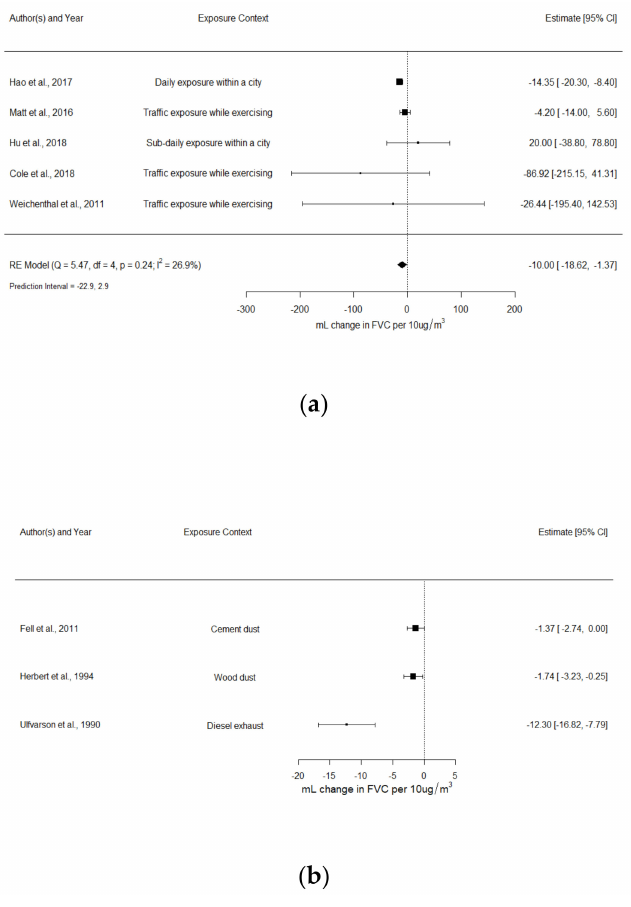
Figure 3. ( a ) Environmental PM 2.5 and FVC (mL changes); ( b ) occupational PM 4 and FVC (mL changes). Random-effect meta-estimate of association is indicated by vertical point of diamond and 95% CI is represented by horizontal point. Squares represent individual effect size of primary studies and the bars the 95% CI; size of squares is proportional to weight in calculating random-effect summary estimates. Pooled effect sizes were estimated per 10 µ g/m 3 increase in exposure level. Daily exposure is defined as a 24 h exposure duration, while sub-daily is defined as an exposure duration <24